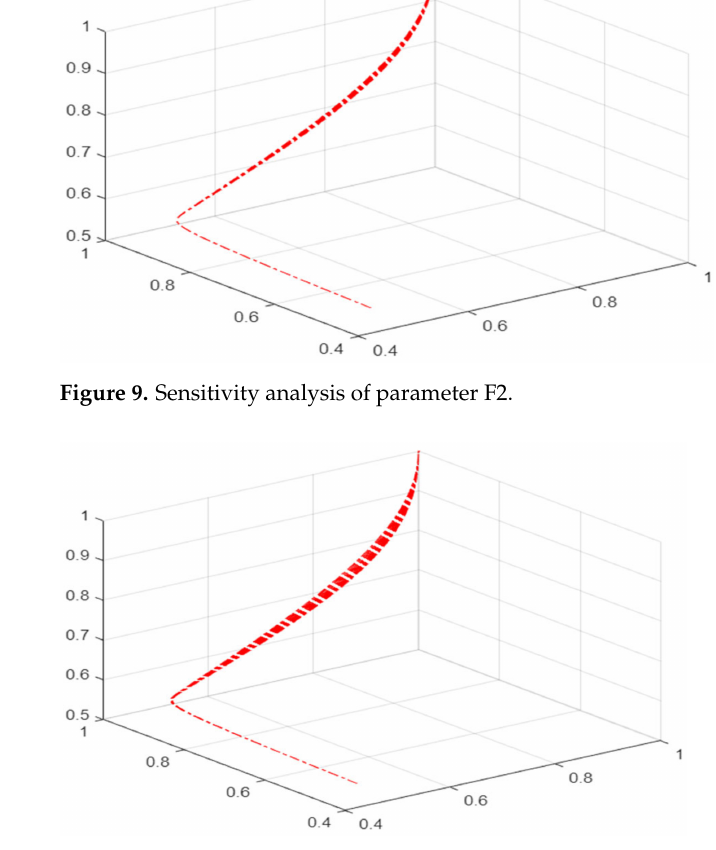
Figure 10. Sensitivity analysis of parameter